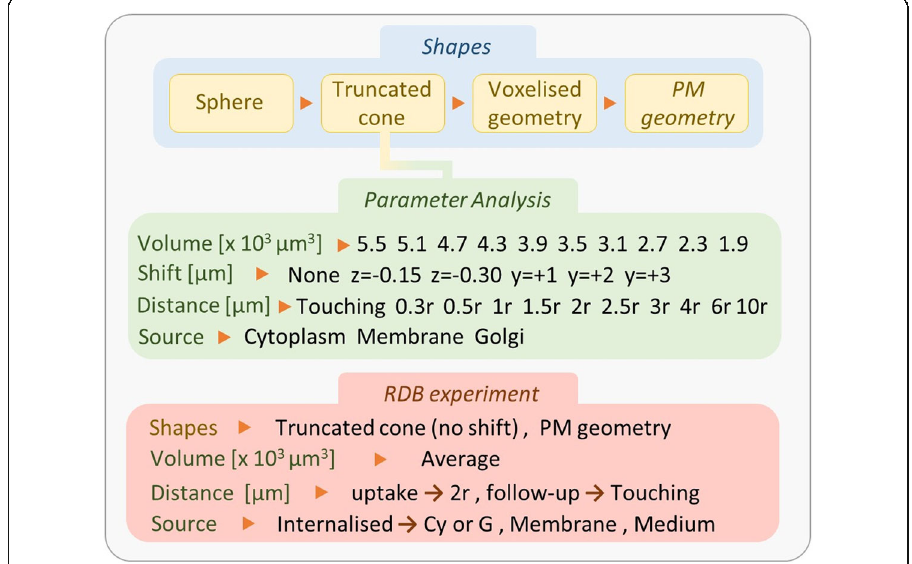
Fig. 3 Schematic summary of the simulations performed for the parameter analysis with the truncated cone geometry (green area) and the in vitro experiment (red area). The position shifts of the nucleus are referred to the z - and y -axis. The relative distance between cells is indicated as multiples of the cell radius ( “ r ” ). Regarding the simulation of the in vitro experiment, during the 4-h uptake, the distance between cells was assumed constant and evaluated on average (1 cell diameter); in the next 6 days, cells were able to form colonies made of neighboring